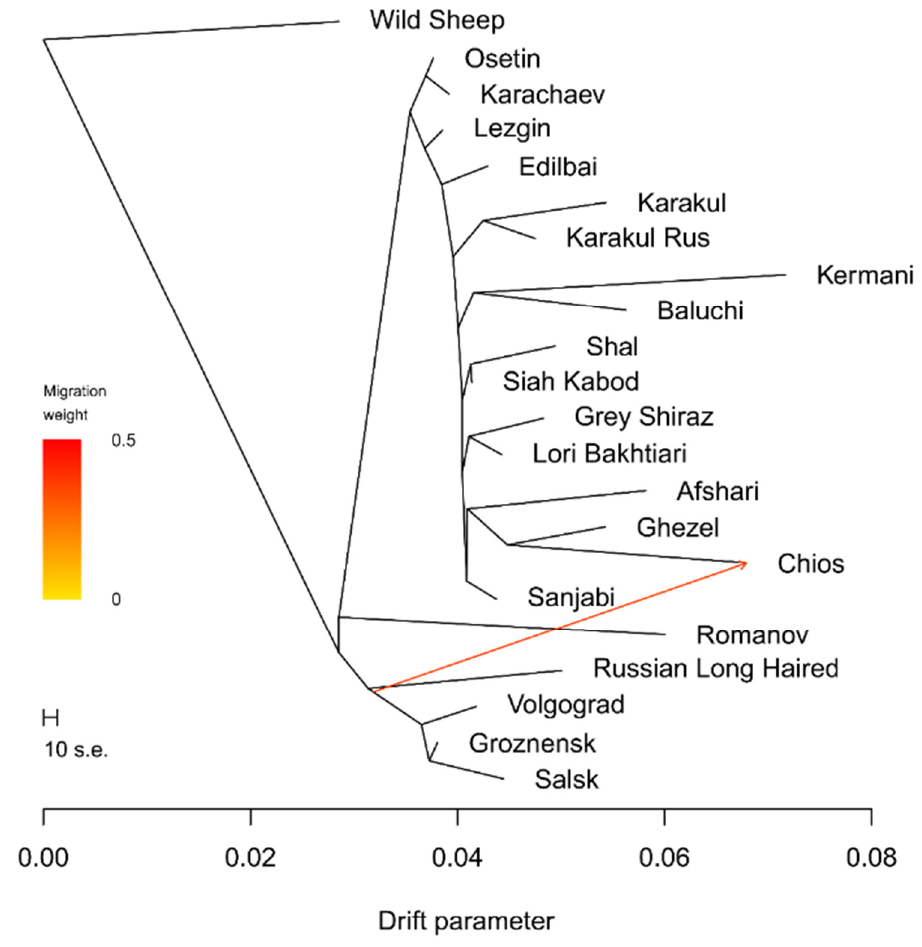
Figure 4. Phylogenetic network inferred by Treemix plot of the relationships between the Iranian and Russian sheep breeds with one migration event.